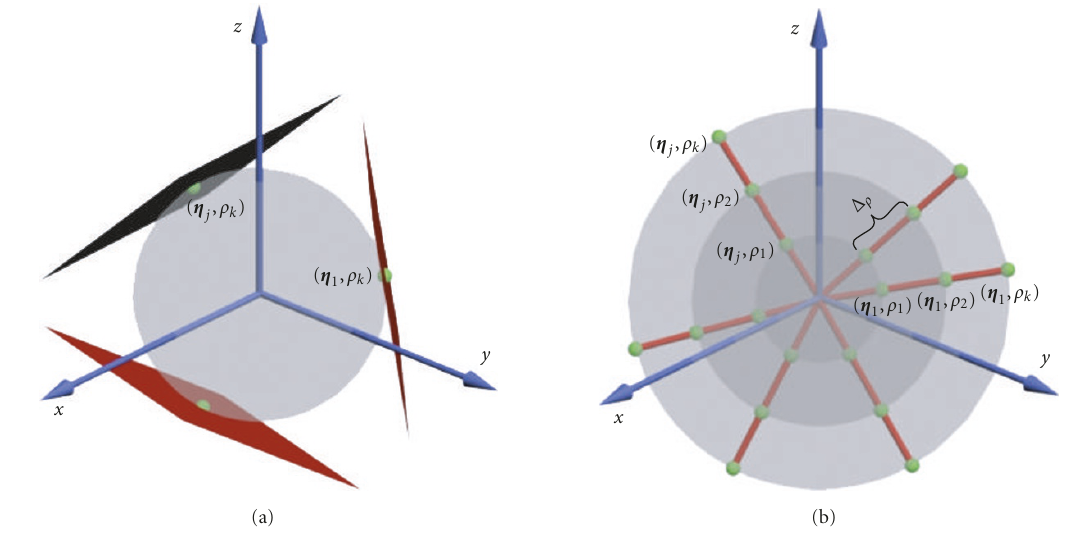
Figure 1: The spherical trace